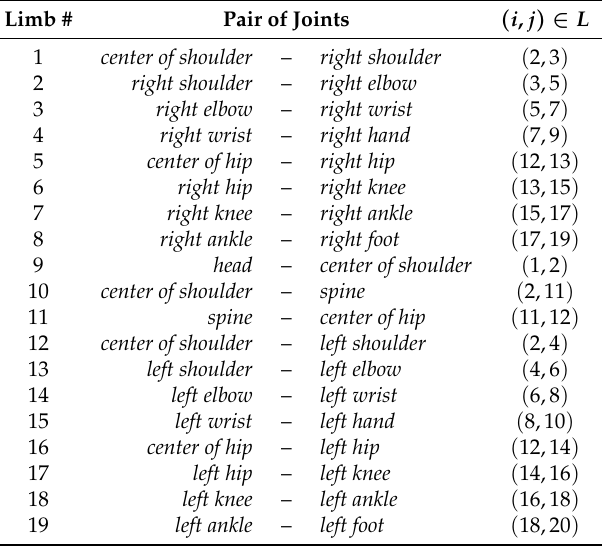
Table 2. Limb information of 3D human skeleton from Kinect